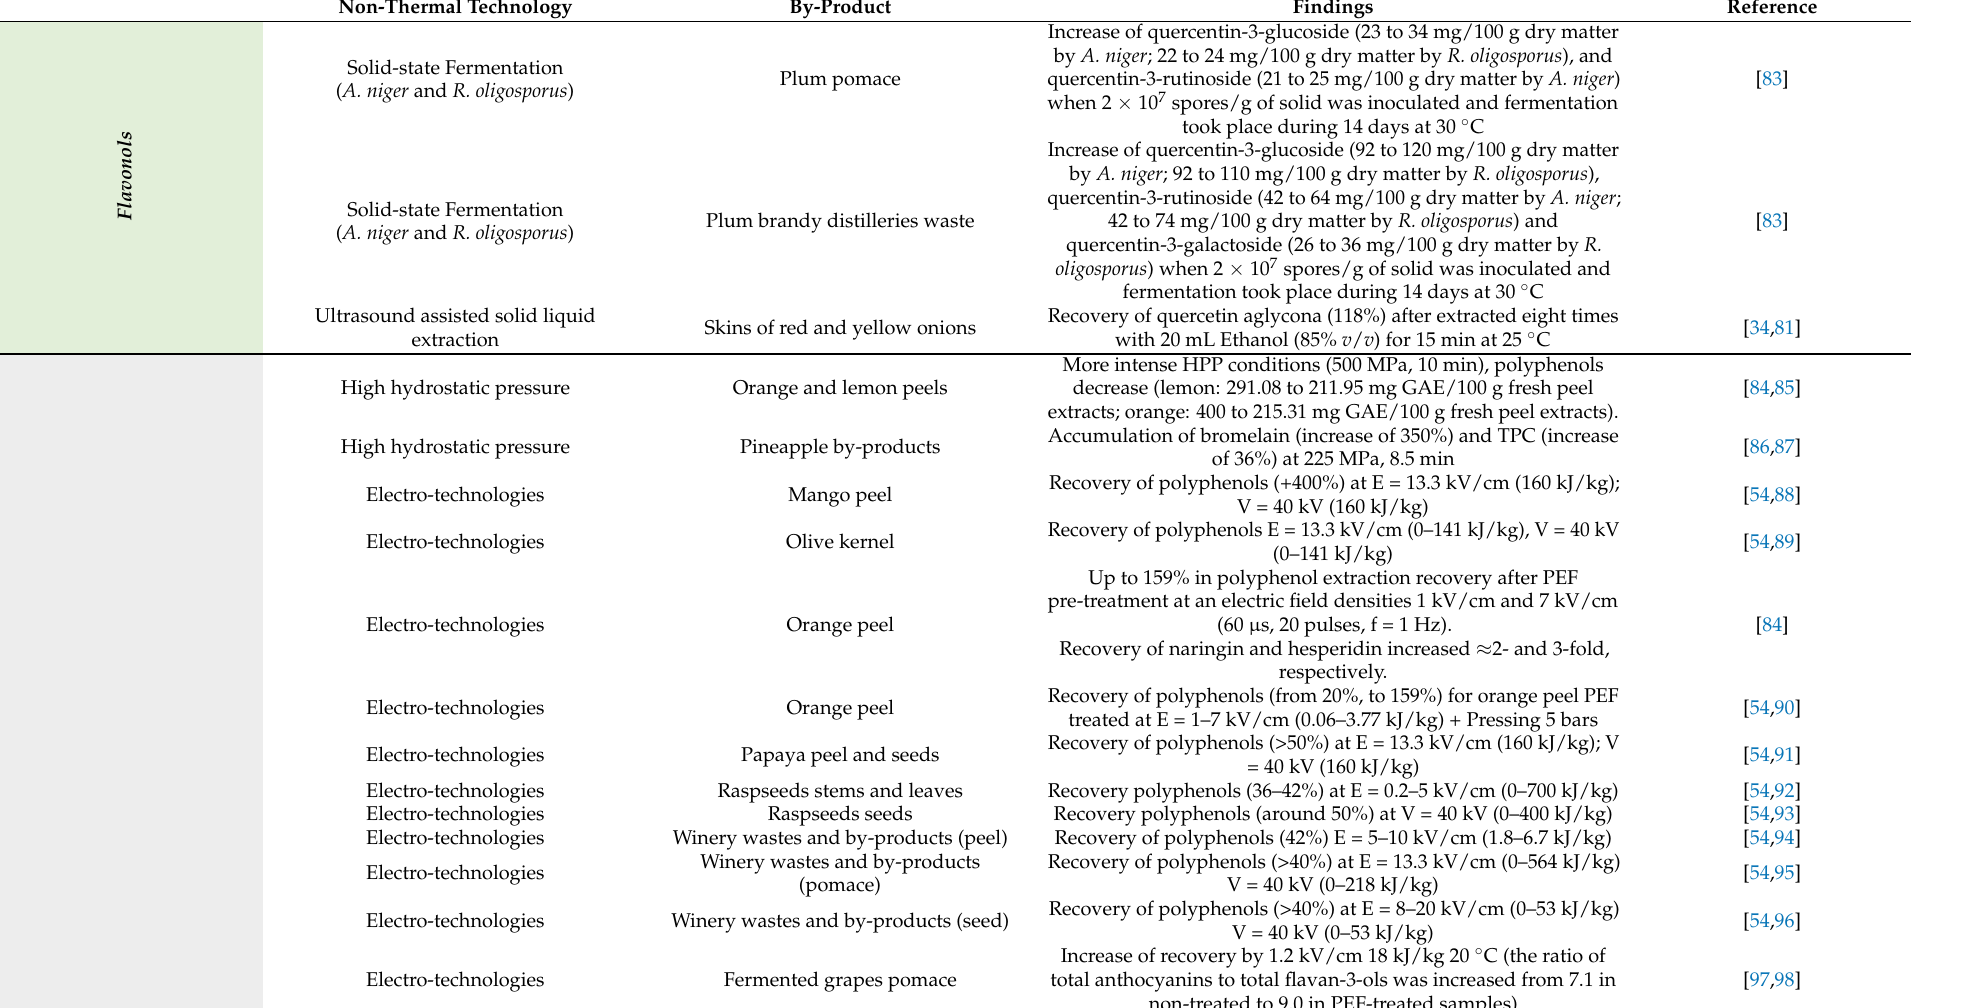
Table 1. Effect of non-thermal technologies on F&V b-products polyphenols (flavonols, total polyphenols,